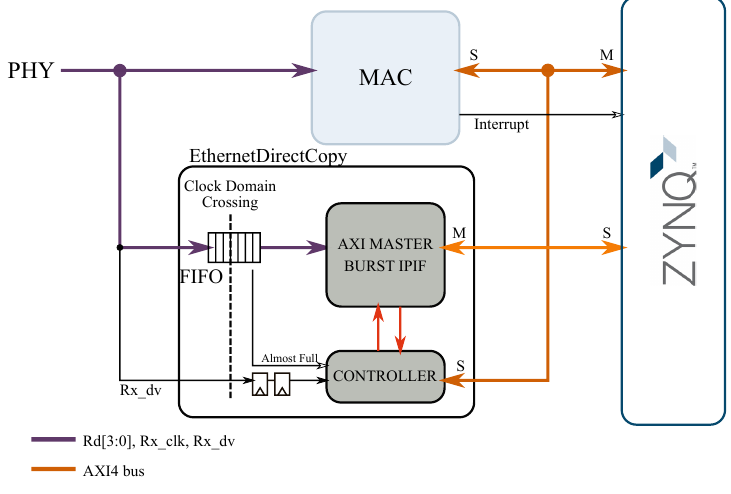
Figure 8. Ethernet Direct Copy hardware accelerator block